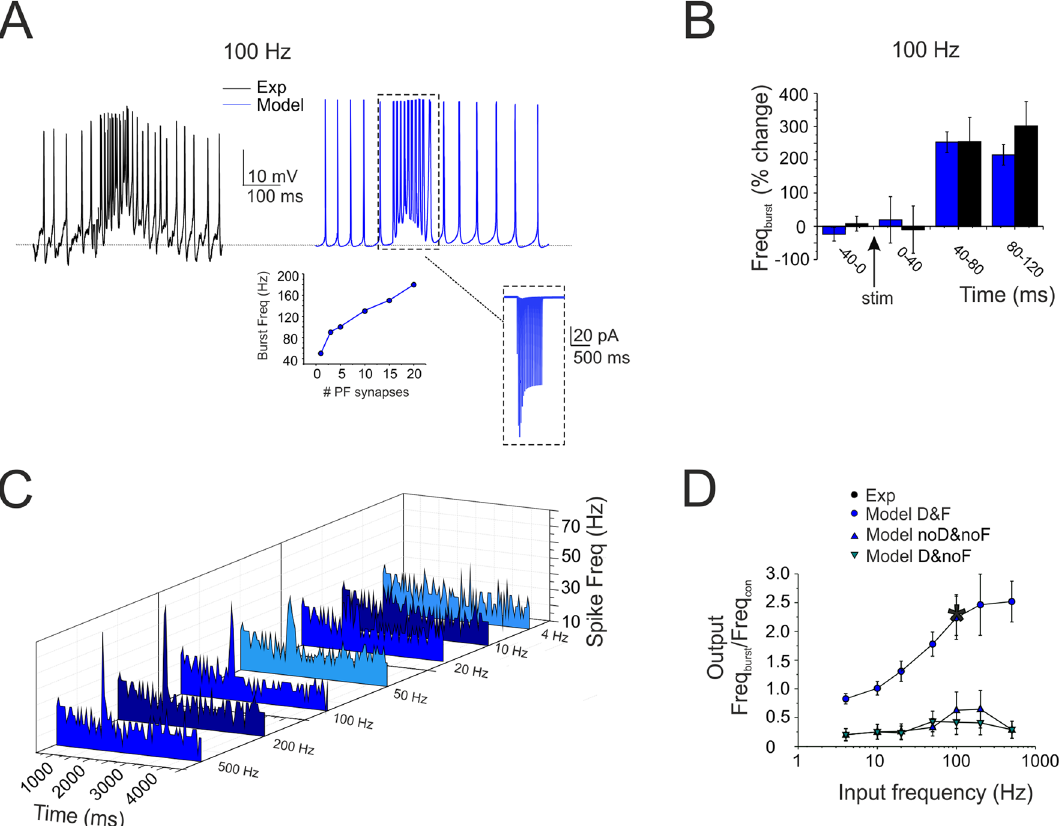
Figure 6. Frequency-dependence of SC input–output gain function. (A) The traces show a SC burst in response to 10 pulses @ 100 Hz-delivered to PFs (black trace) and the corresponding simulation (blue trace). Inset (left), calibration of the number of PF-SC synapses required to obtain a given burst frequency (3 in the example). Inset (right), the synaptic current (AMPA + NMDA) corresponding to the simulated burst. (B) The histogram shows the time course of the SC burst shown in A in response to 10 pulses @ 100 Hz-delivered to PFs (black trace) and the corresponding simulation (blue trace). Note the about 50 ms delay to burst response. (C) The array of PSTHs shows the SC responses to PF bursts at different frequencies (10 pulses @ 4 Hz, 10 Hz, 20 Hz, 50 Hz, 100 Hz, 200 Hz, 500 Hz). Note that pronounced spike bursts were generated at high frequencies (e.g. at 100 Hz). (D) Input/output SC gain for experimental (black, n = 5) and simulated bursts (blue, n = 4). SCs did not increase their spike output frequency until about 10 Hz, then their responses increased and tended to saturate beyond 100 Hz. Note the superposition of the single experimental data point and simulated data (asterisk). The simulation was repeated after the switch-off of STF (τ facil = 10 times the original) and STD (τ rec = 0), revealing their critical role for the frequency-dependence of the input–output function. Data in B and D are reported as mean ± SEM (n = trains. GABA A receptors generated SC inhibitory currents. Interestingly, the kinetics of synaptic response trains showed strong facilitation (STD followed the first impulses at > 50 Hz) that, in the model, implied a low neuro- transmitter release probability ( p = 0.15). Consequently, the SCs generated spikes with a delay (about 50 ms during a 100 Hz train) and prevented responses to single PF spikes. This mechanism therefore effectively controls the timing of SC responses to bursts at the same time preventing their activation by single sparse PF spikes, which are therefore filtered out as noise. As long as the models predict that SCs operate as delay-high-pass filters, they also anticipate the underlying mechanisms. The SC gain curves were enhanced by NMDA and reduced by GABA A receptor-mediated trans- mission, this latter also shifting the cut-off frequency from ~ 50 Hz to ~ 100 Hz. The frequency-dependent effect reflected the short-term synaptic dynamics typical of these neurons and were enhanced by activation of NMDA currents and voltage-dependent ionic currents (mostly the LVA calcium current). GABA A currents reduced the cell input resistance and prevented regenerative depolarizing effects (see also Supplemental Material). Stellate cell regulation of Purkinje cell gain. The electrophysiological and imaging analysis of sig- nal propagation and neuronal excitation 17–19,63 has revealed that granular layer signals are retransmitted to PCs vertically at high frequency along GrC ascending axons and then transversally at low frequency along PFs 73 . The present simulations indeed provide a plausible mechanism for this dual nature of transmission properties through the granular and molecular layer. This view substantially differs from the classical “beam theory” 4,74 ,